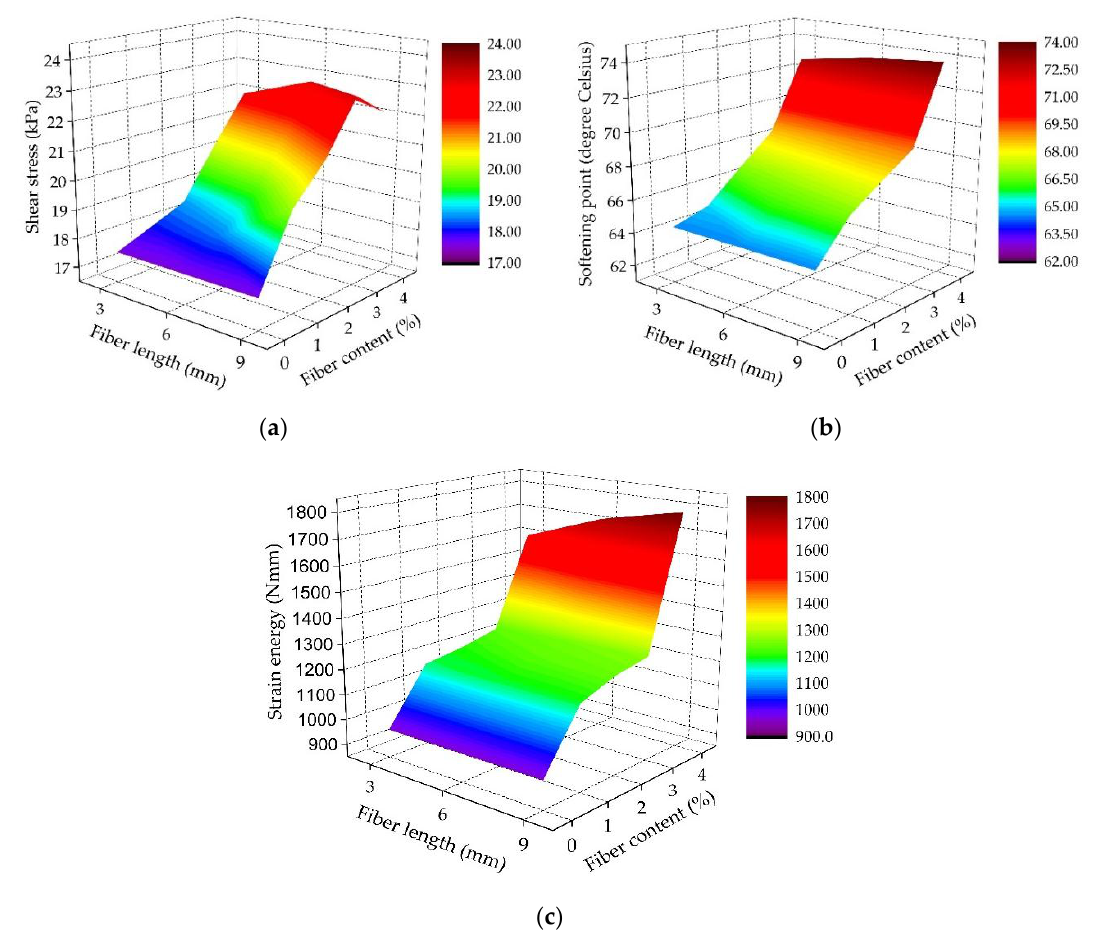
Figure 5. Test results of modified asphalt binders in this study: ( a ) Cone penetration test; ( b ) Softening point test; ( c ) Force ductility test.